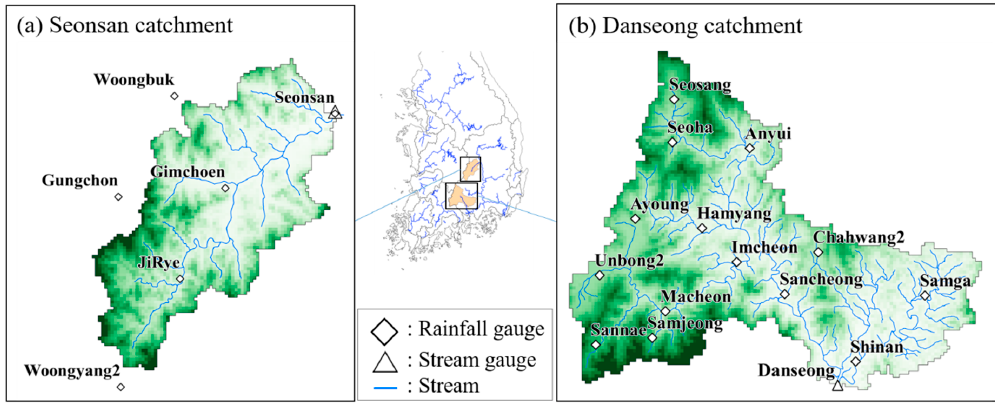
Figure 1. Maps of the study areas: ( a ) Seonsan catchment and ( b ) Danseong catchment in South Korea. The rainfall data used in this study are eight rainfall events that occurred in Danseong and Seonsan catchments (Table 1). The average rainfall data for each catchment were generated by the Thiessen Polygon method, using the observed rainfall of the rainfall stations (Figure 1). The rainfall stations are operated by the Ministry of Land, Infrastructure and Transport (http://www.molit.go.kr). The time interval of the data was 10 min, and the precipitation amounts varied from 43 mm to 225 mm. The precipitation time distribution of the rainfall events, and resulting hydrographs, show substantial variation (Figure 2). Table 1. Storm events for each catchment.